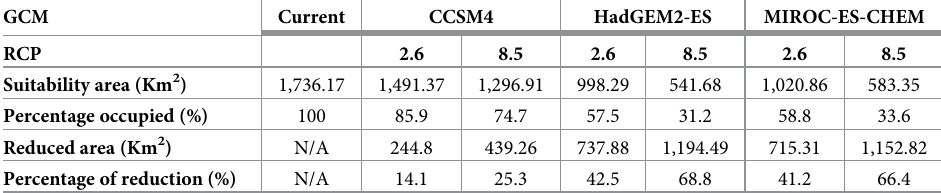
Table 4. Comparison between the suitability areas estimated by the current and future different general circula- tion models (GCM) for two Relative Concentration Pathways (RCP’s) used for 2070.